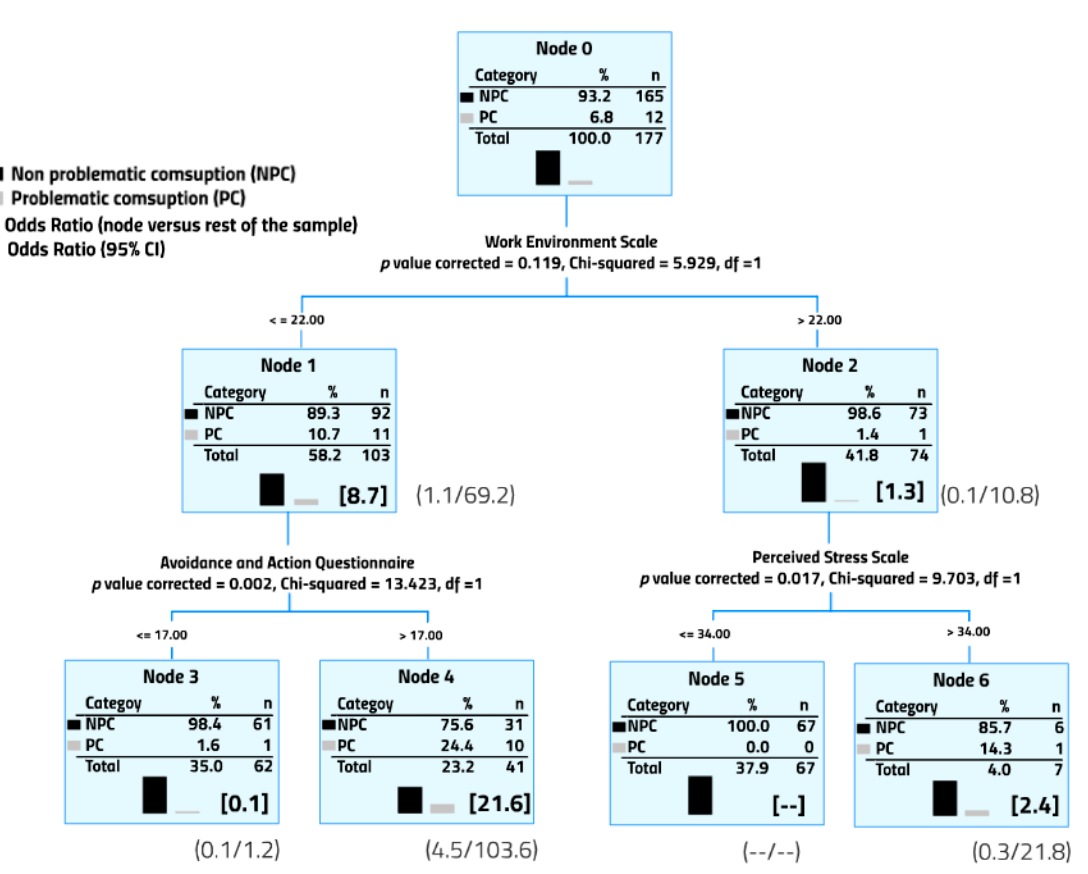
Figure 2. Female professor subsamples identified based on the degree of problematic alcohol consumption. All variables considered in the study were included in the CHAID analysis.